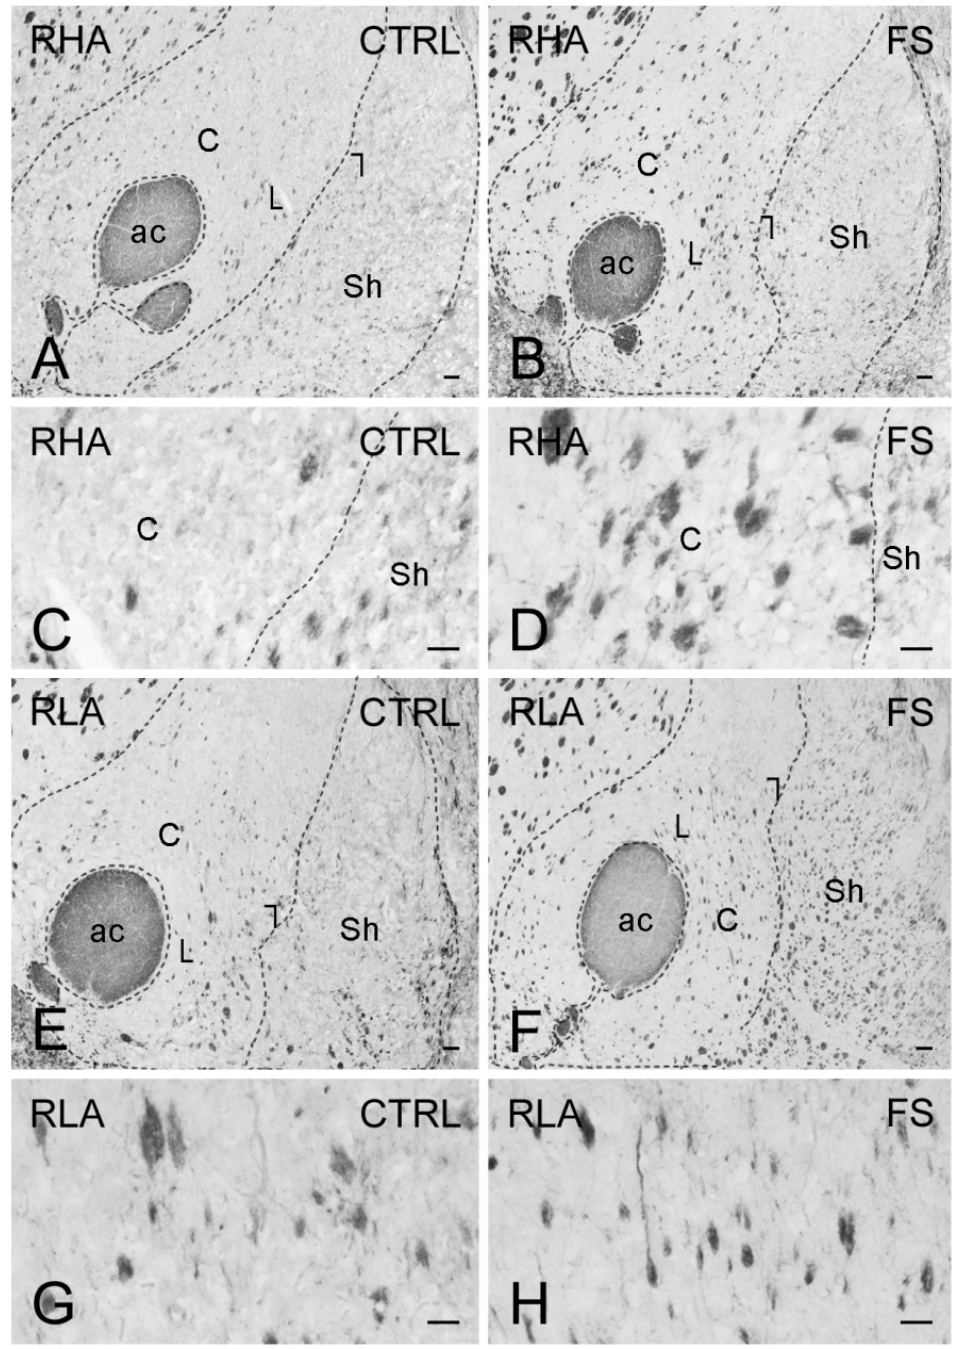
Figure 8. Brain-derived neurotrophic factor-like immunoreactivity (BDNF-LI) in the nucleus ac- cumbens (Acb) of RHA ( A – D ); and RLA rats ( E – H ) under baseline condition (CTRL) and after a 15 min session of forced swimming (FS). ( A , B , E , F ) low power view of Acb. Dashed lines mark the boundaries of the Acb shell (Sh) and core (C) subregions. Areas squared in ( A , B , E , F ) indicate the microscopic field in ( C , D , G , H ), respectively. ac, anterior commissure. Scale bars: ( A , B , E , F ) = 250 µm; ( C , D , G , H ) =25 µm.